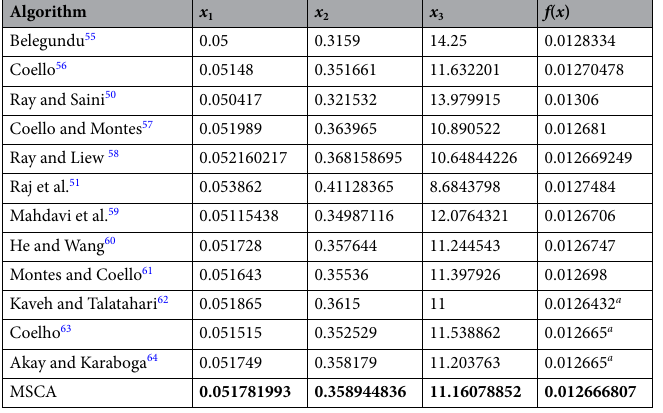
Table 13. The best solution for tension string design problem. a means infeasible. Significant values are in bold.